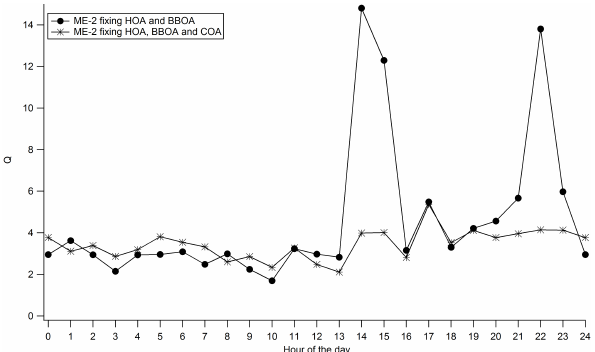
Figure 3. Comparison of the diurnal pattern of the Q-value for the 5-factor solution constraining HOA-BBOA or HOA-BBOA-COA (Barcelona 2009). The structure in the scaled residuals suggests the presence of additional